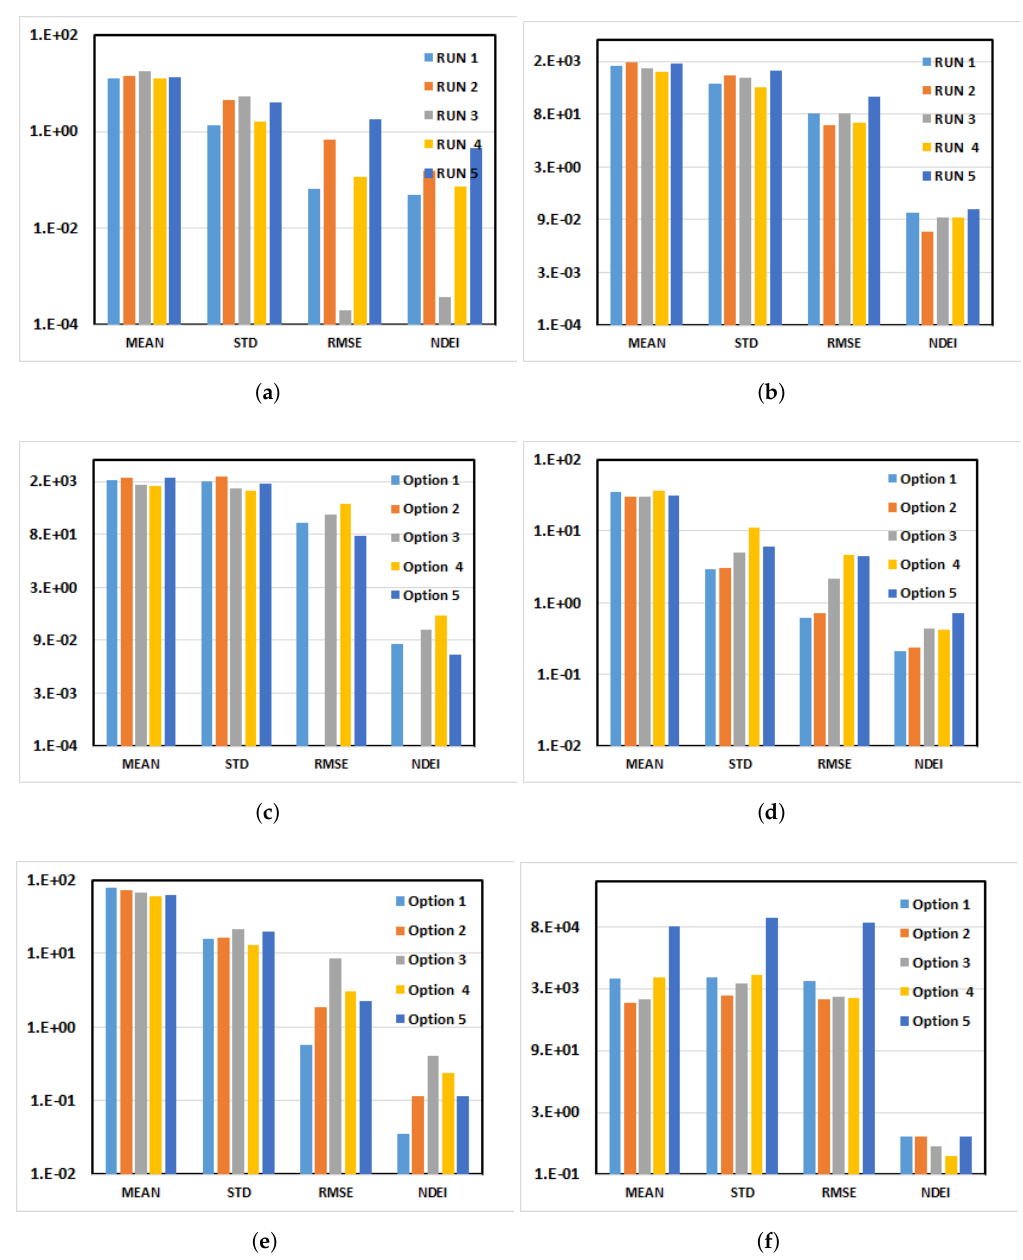
Figure A1. Statistical data plots of worldwide successful steam injection EOR projects for the variables: ( a ) API; ( b ) depth; ( c ) permeability; ( d ) porosity; ( e ) saturation; and ( f )